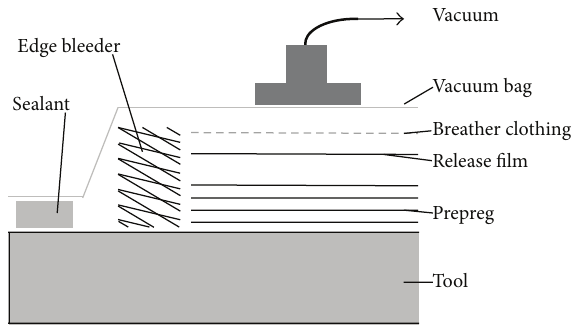
Figure 1: Autoclave entire lay-up